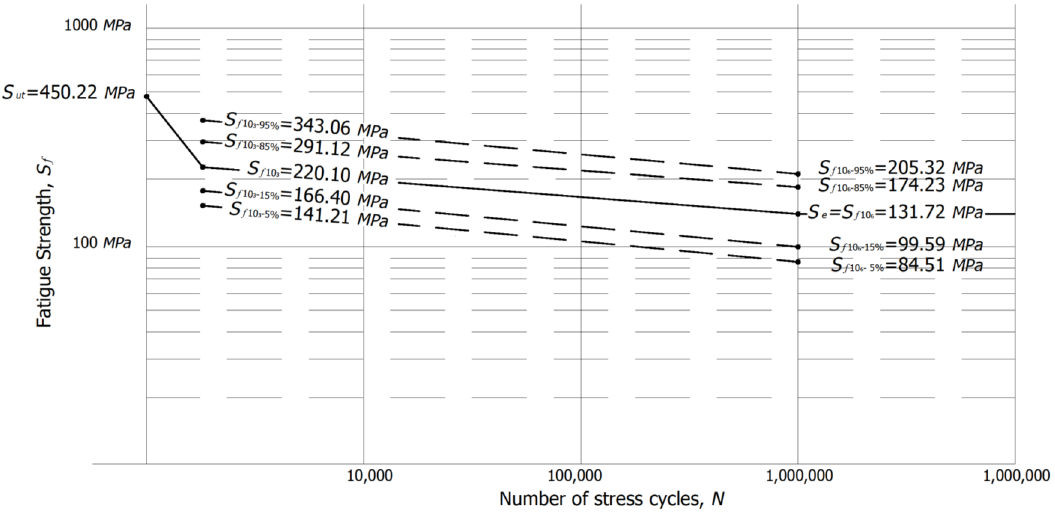
Figure 3. Probabilistic S-N curve for the A572 Gr. 50 steel, based on the Weibull distribution.